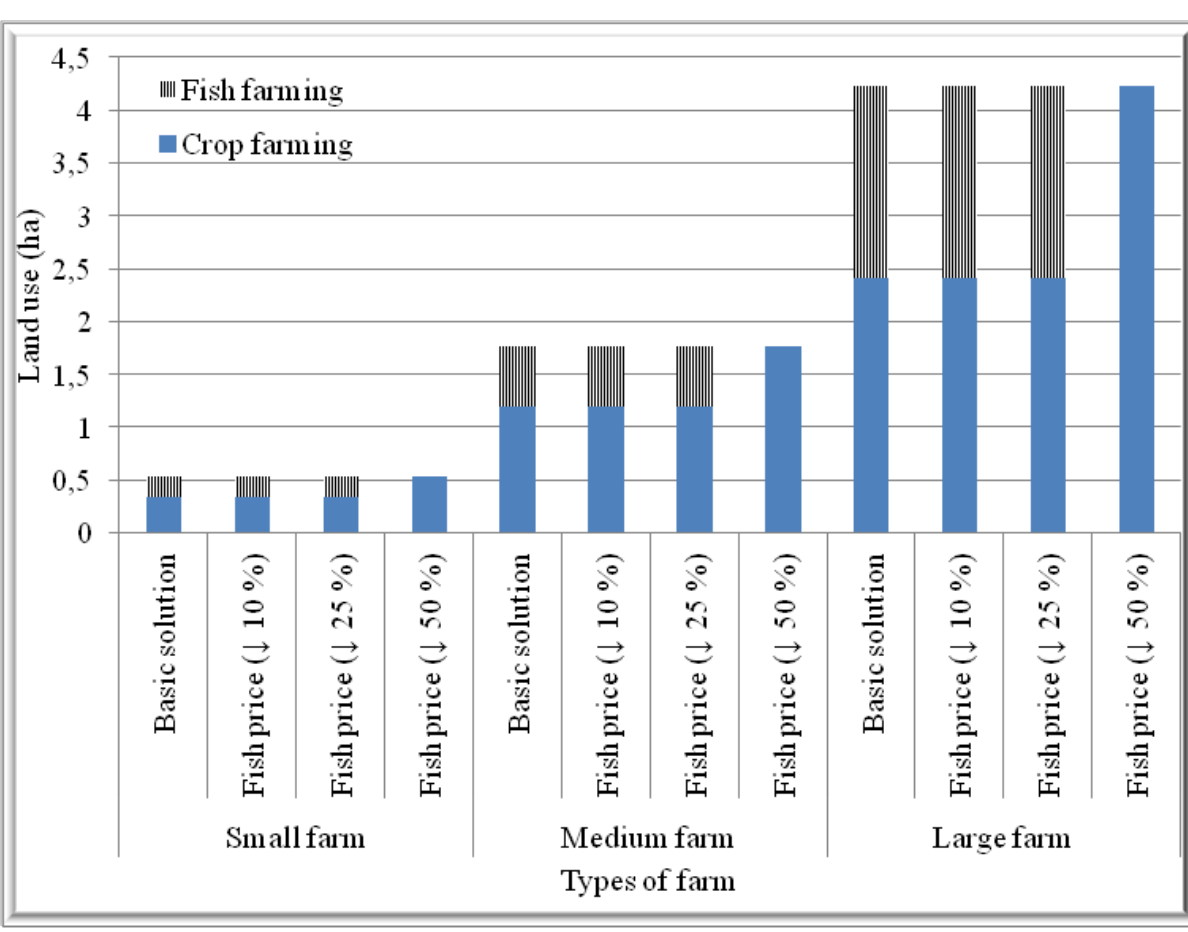
Fig. 2: Fish price decreasing and land use pattern of the farmers. Source: Author’s